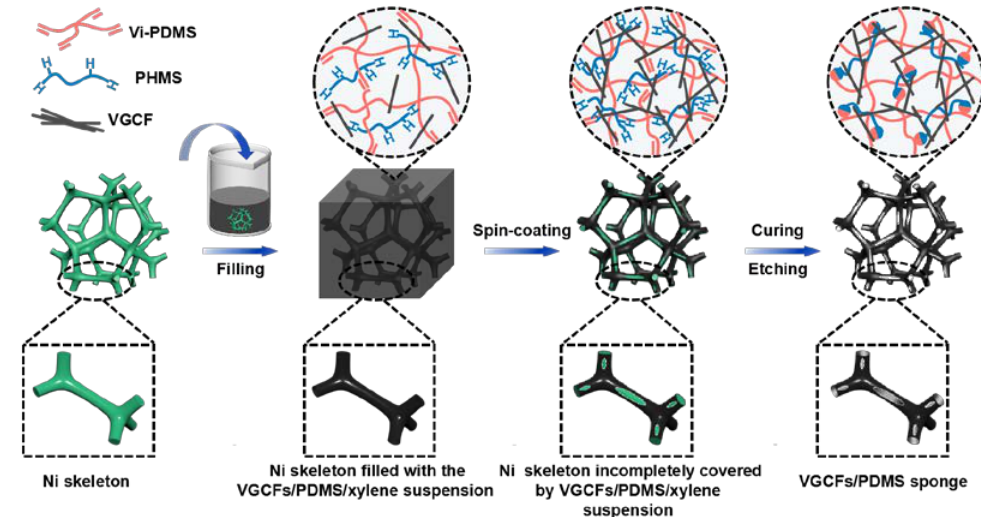
Figure 1. Fabrication schematic of VGCFs/PDMS sponge (CPS) via applying the dip-spin-coating